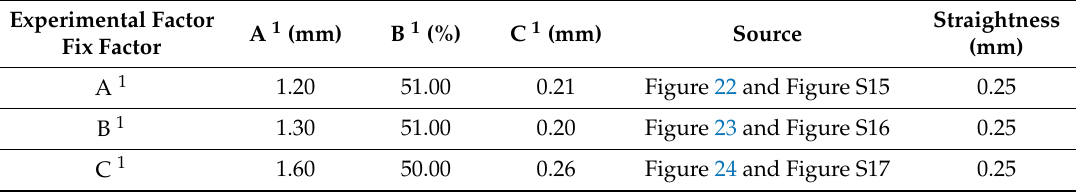
Table 6. Value of Experimental Factor for Straightness